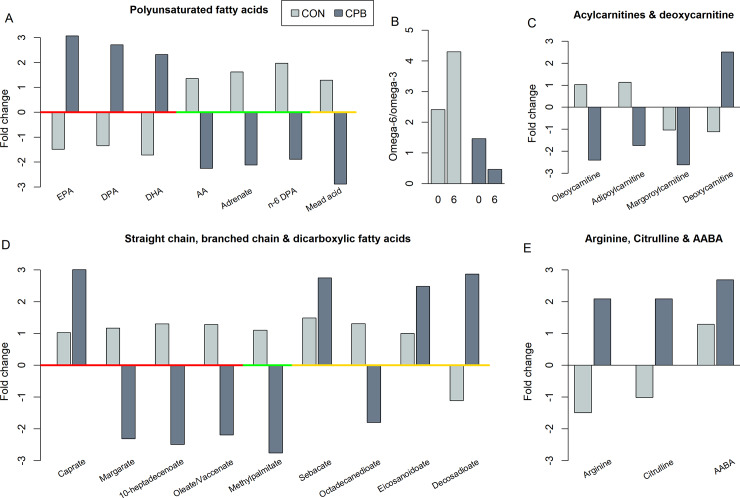
Fold changes between CPB vs. CON diets in (A) polyunsaturated FAs, (B) ratios of omega-6 to omega-3 FAs, (C) acylcarnitines and deoxycarnitine, (D) straight chain, branched chain, and dicarboxylic FAs, and (E) L-arginine, L-citrulline, and 2-aminobutyric acid (AABA) at baseline (0) and 6 months (6). Red, green, and gold bars along x-axis depict (A) omega-3, -6, and -9 FAs respectively and (D) straight, branched chain, and dicarboxylic FAs respectively. A negative fold change represents a decrease from baseline to 6 months.